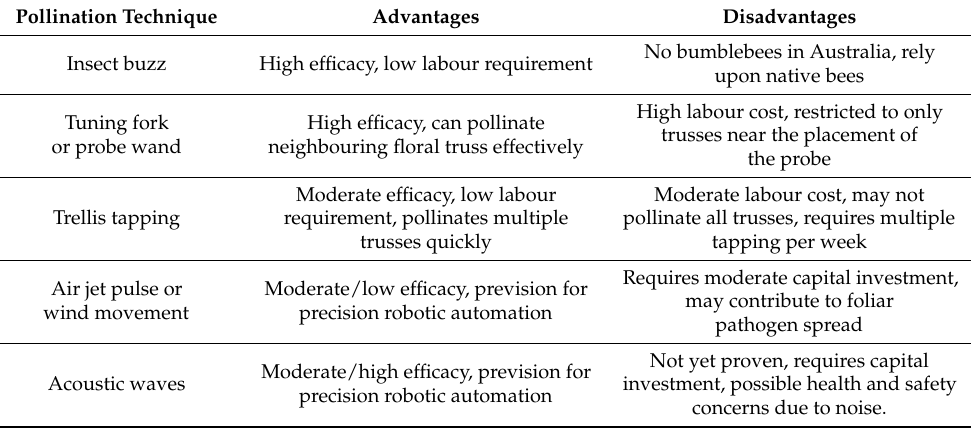
Table 3. Advantages and disadvantages of the different techniques available to pollinate tomato flowers in the protected-cropping